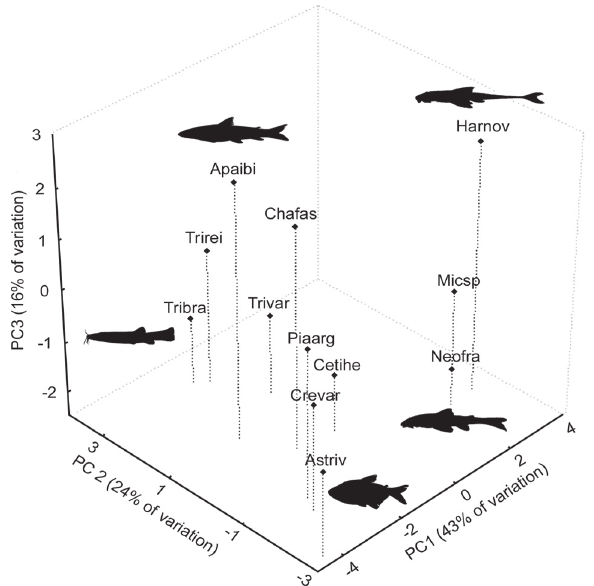
Fig. 3. Projection of the first three PCA axes based on 14 ecomorphological attributes for the following